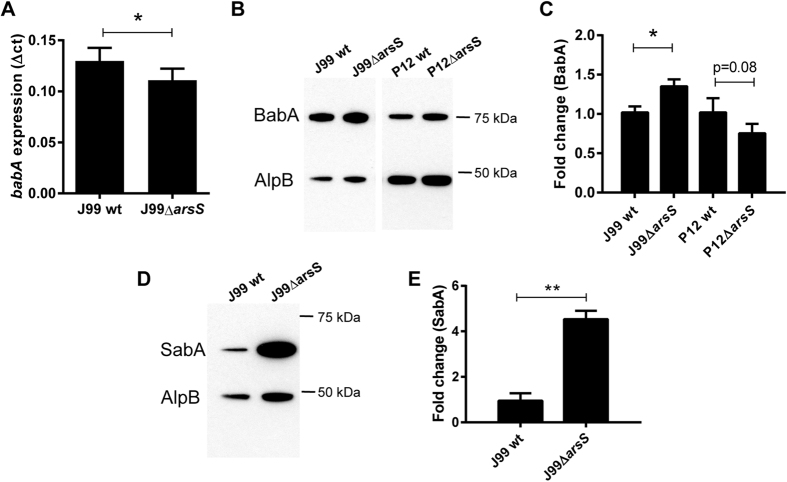
Effect of arsS deletion on BabA/babA expression.(A) mRNA expression of babA in J99 wt and J99ΔarsS. Expression of babA after 24 h of culture in liquid medium, measured as ΔCt in relation to 16 S rRNA as a housekeeping gene. Stars indicate difference in expression compared by paired sample t-test, *p ≤ 0.05, where Ct values of each experiment were paired to remove confounding factors of variable base levels between experiments (n = 3). (B) Immunoblot detecting BabA in bacterial lysates after growth on plate. AlpB was used as a loading control. (C) Quantification of the BabA immunoblot, normalized to AlpB (n = 5–7). (D) Immunoblot detecting SabA in J99 lysates. AlpB was used as a loading control. (E) Quantification of the SabA immunoblot, normalized to AlpB (n = 5–8). Data are presented as median with interquartile range, and analyzed with the Mann-Whitney U-test (*p ≤ 0.05, **p ≤ 0.01).